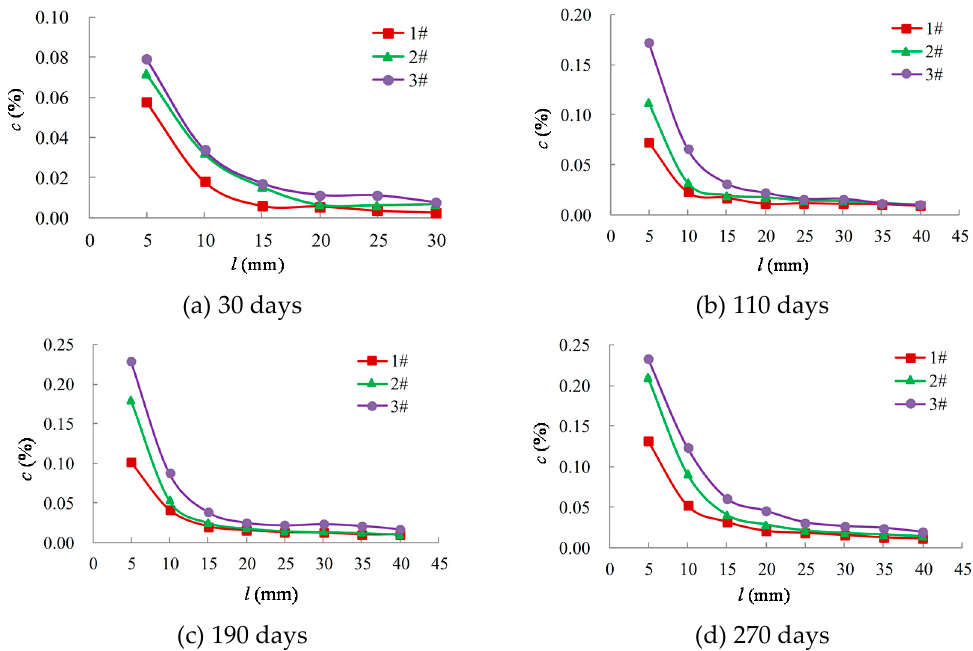
Figure 2. The change curves of chloride ion concentration, c , with depth, l.